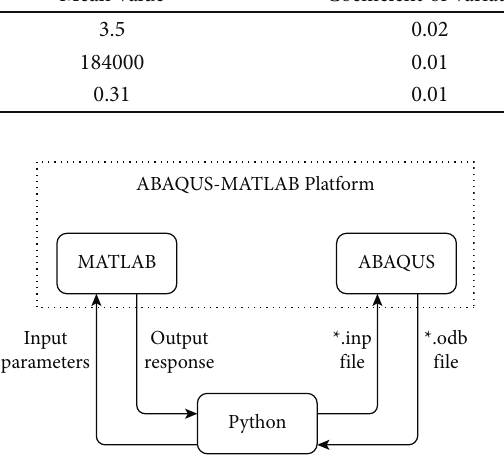
Figure 15: System structure